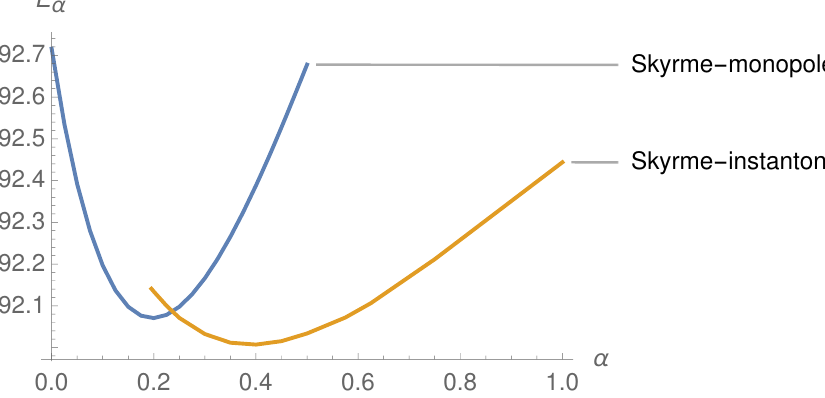
Figure 10. A phase diagram of the energies of Skyrme-monopoles and Skyrme-instantons for varying (cid:11) 2 [0 ;